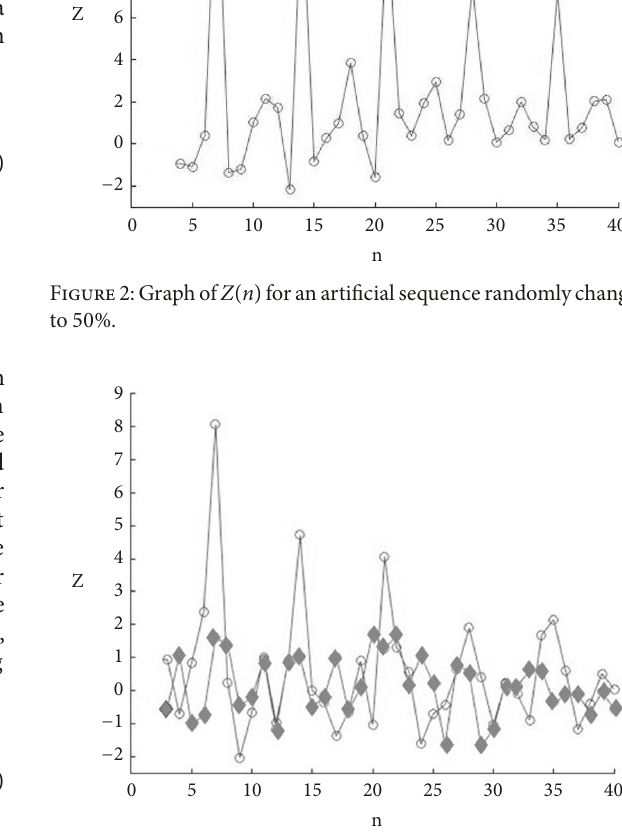
Figure 3: Graph Z ( n ) for an artificial sequence containing 60% random base substitutions with the addition of 8 inserts and 12 deletions (circles) and Z ( n ) for a random sequence